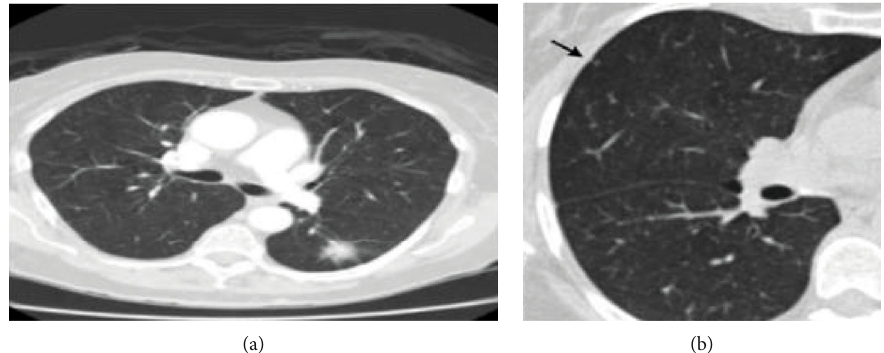
Figure 1: (a) Lung cancer nodule view. (b) An arrow indicates this 1.25mm thick CT slice to contain approximately 2mm long lung nodules.